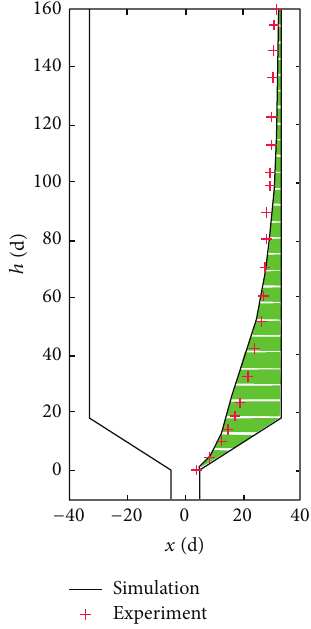
Figure 3: The mean-streamline method of the definition of stagnant zone ( 𝑓 = 0.2 , 𝐴 = 30 ∘ , and ℎ = 160